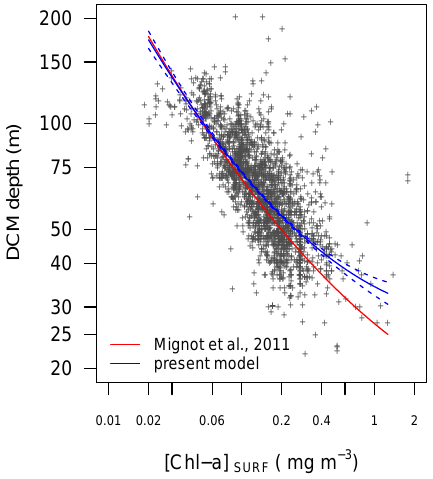
Figure 9. Scatter of the DCM depth as a function of surface [Chl a ]. Only profiles of the DCM standard shape were used for this analy- sis. Surface [Chl a ] were obtained from satellite ocean color data. The blue solid line represents a second-order polynomial model de- termined from present data ( R 2 = 0 . 52) with its confidence inter- vals (blue dotted lines), and the red line represents the model com- puted by Mignot et al. (2011) from a global ocean data